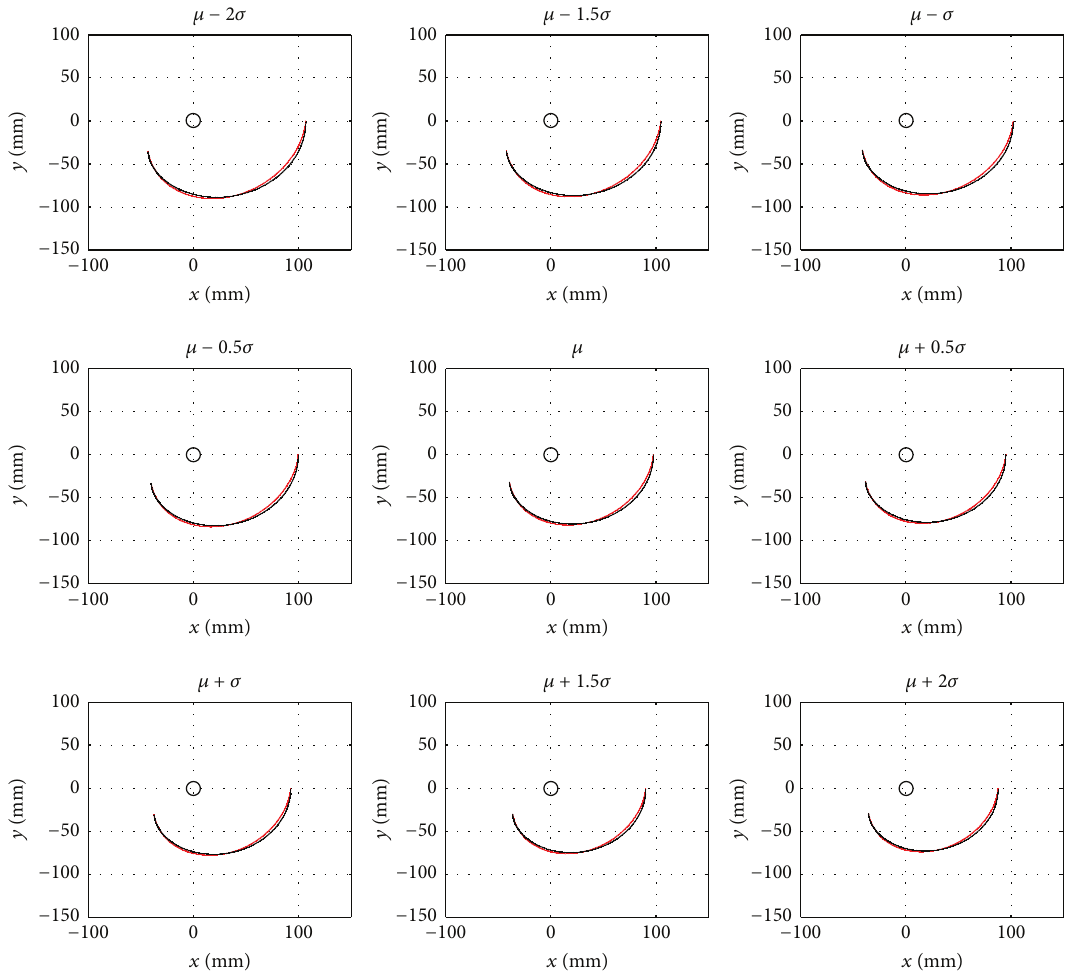
Figure 11: Paths of the middle finger and R-RRT proposed